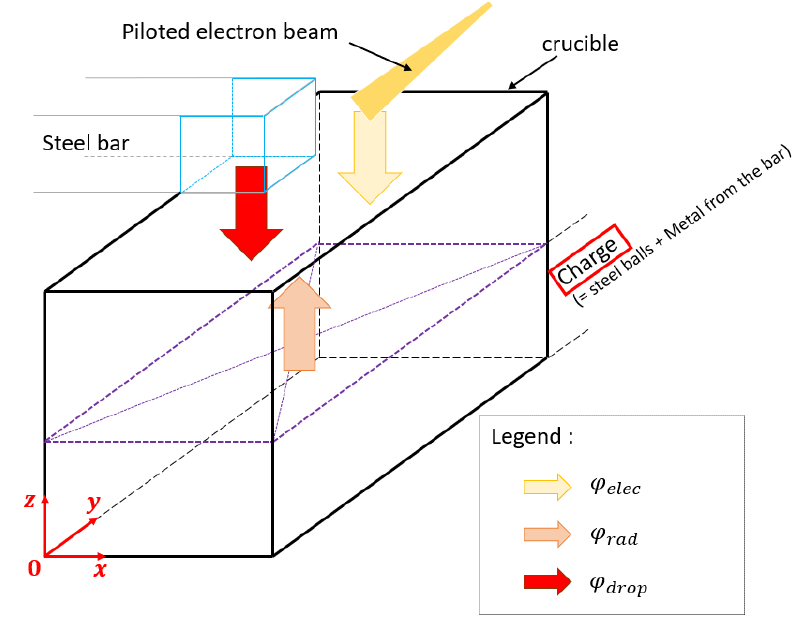
Figure 6. Schematic of the boundary conditions at the top of the crucible.